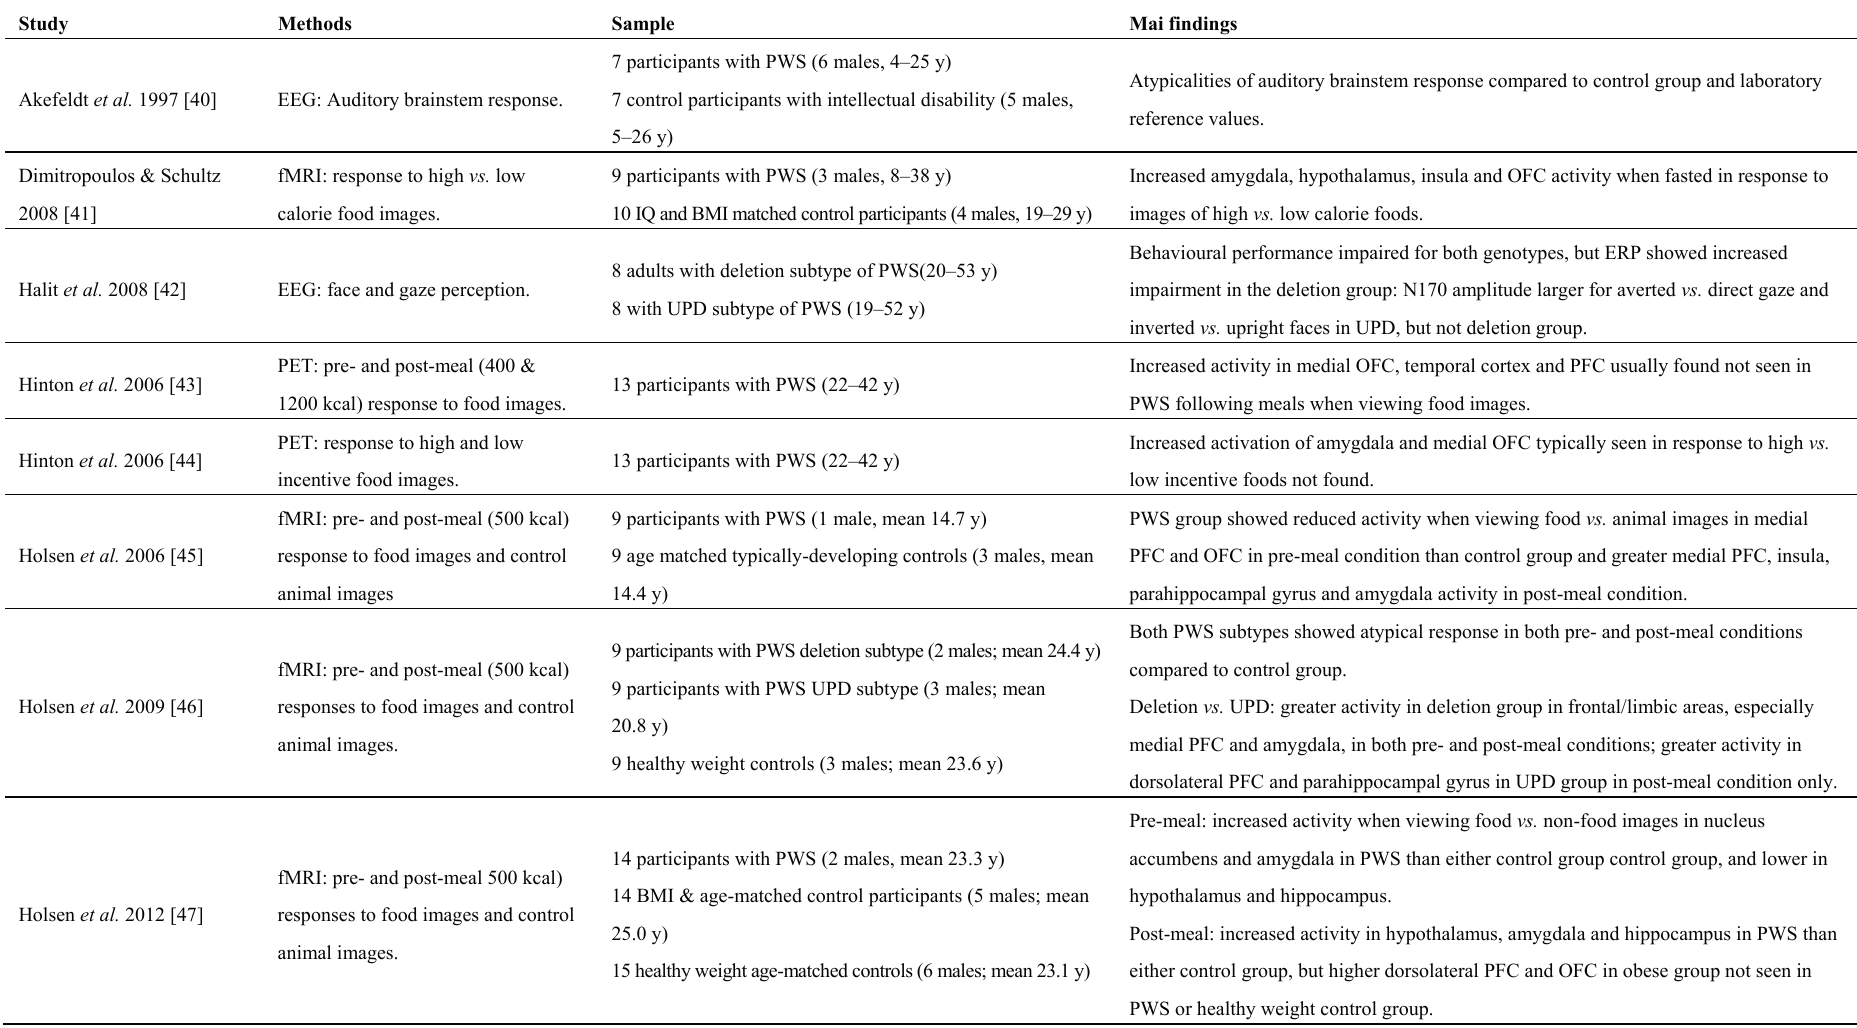
Table 2. Studies reporting neural function in PWS at the macrostructural